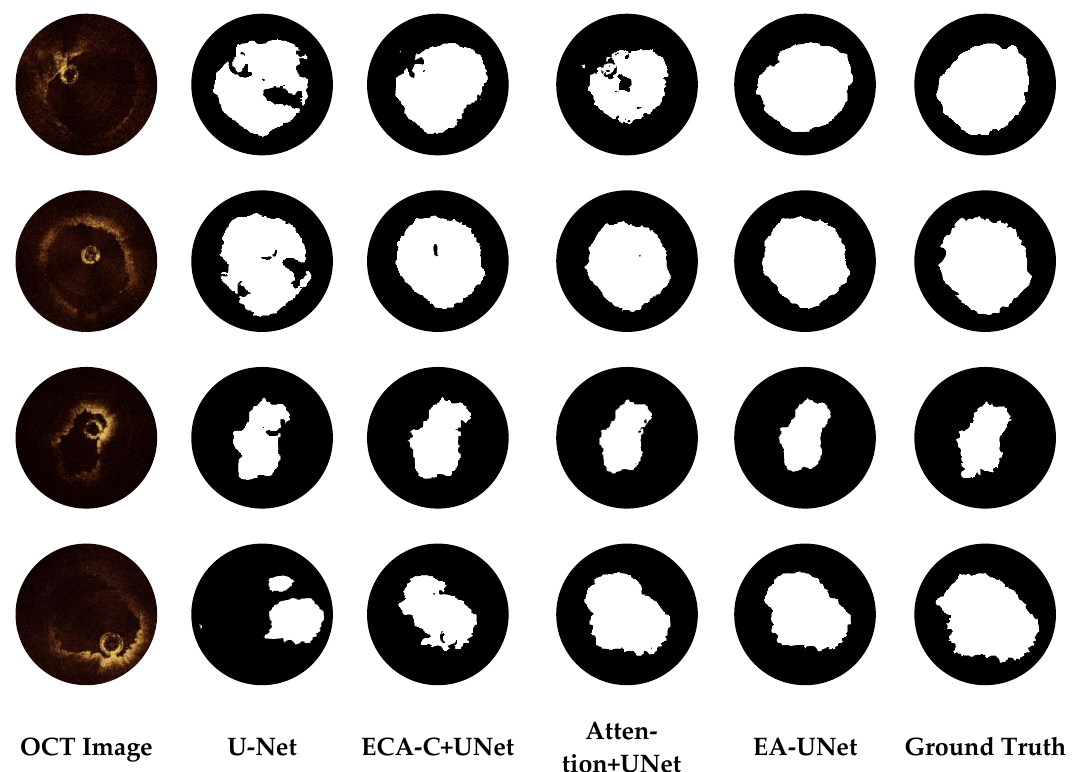
Figure 4. Comparison of ablation experiments of each module of EA-UNet model.